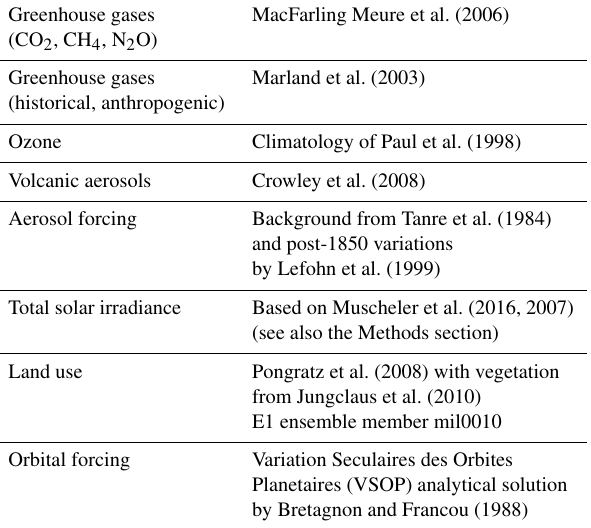
Table 1. List of forcings for the ECHAM5/MPI-OM model simu-